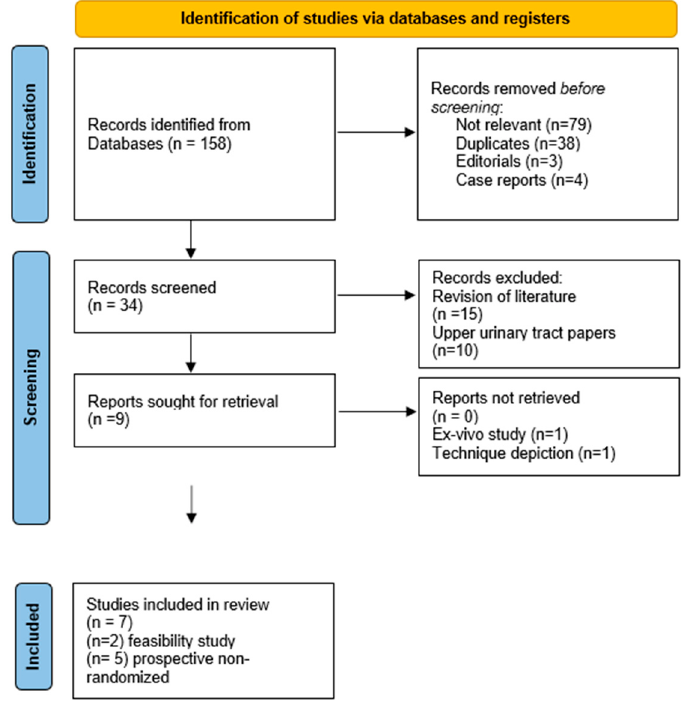
Figure 1. PRISMA study flowchart.